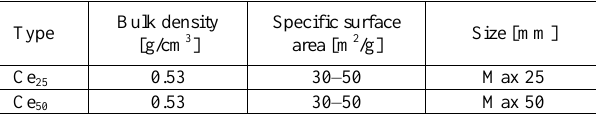
Table 1. Physical characteristics of the materials used